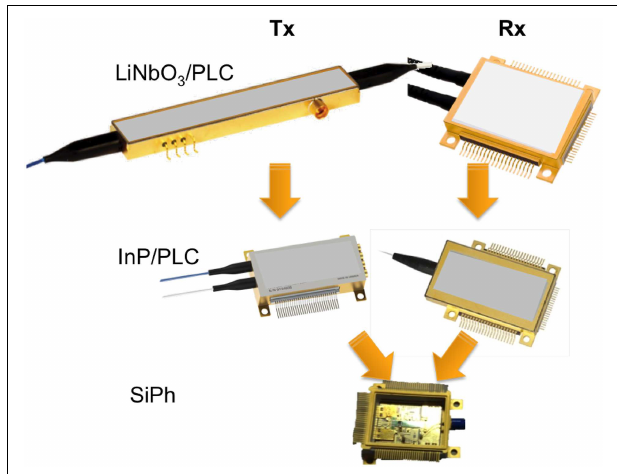
FIGURE 2 | 100-Gb/s coherent optics evolution, going from LiNbO 3 modulators and planar lightwave circuit (PLC)-based receivers to InP-based modulators and receivers to silicon photonic modulators and receivers.